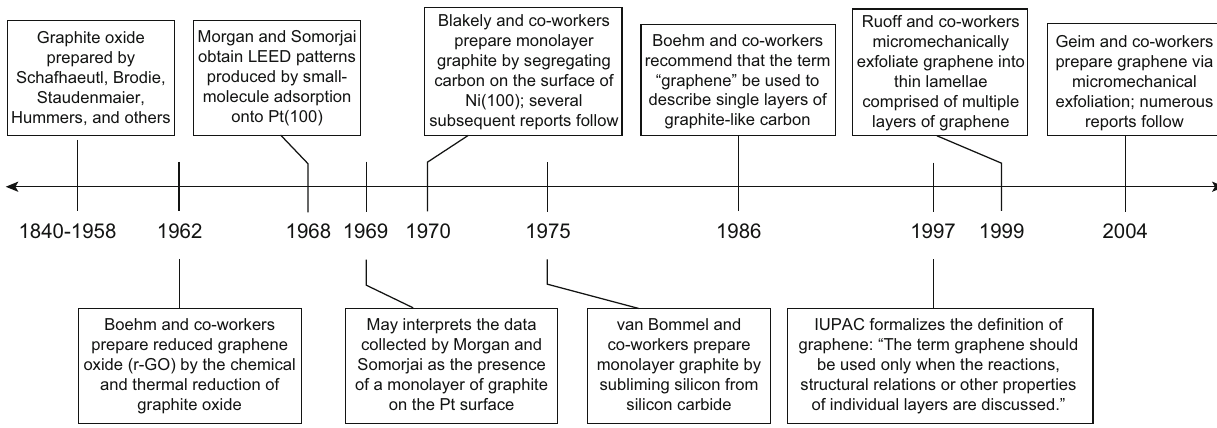
Fig. 2 Timeline of selected events in the history of the preparation, isolation and characterization of graphene (Figures are adapted with permission from Ref. [1]). Copyright (cid:2) 2010 WILEY-VCH Verlag GmbH and Co. KGaA, Weinheim